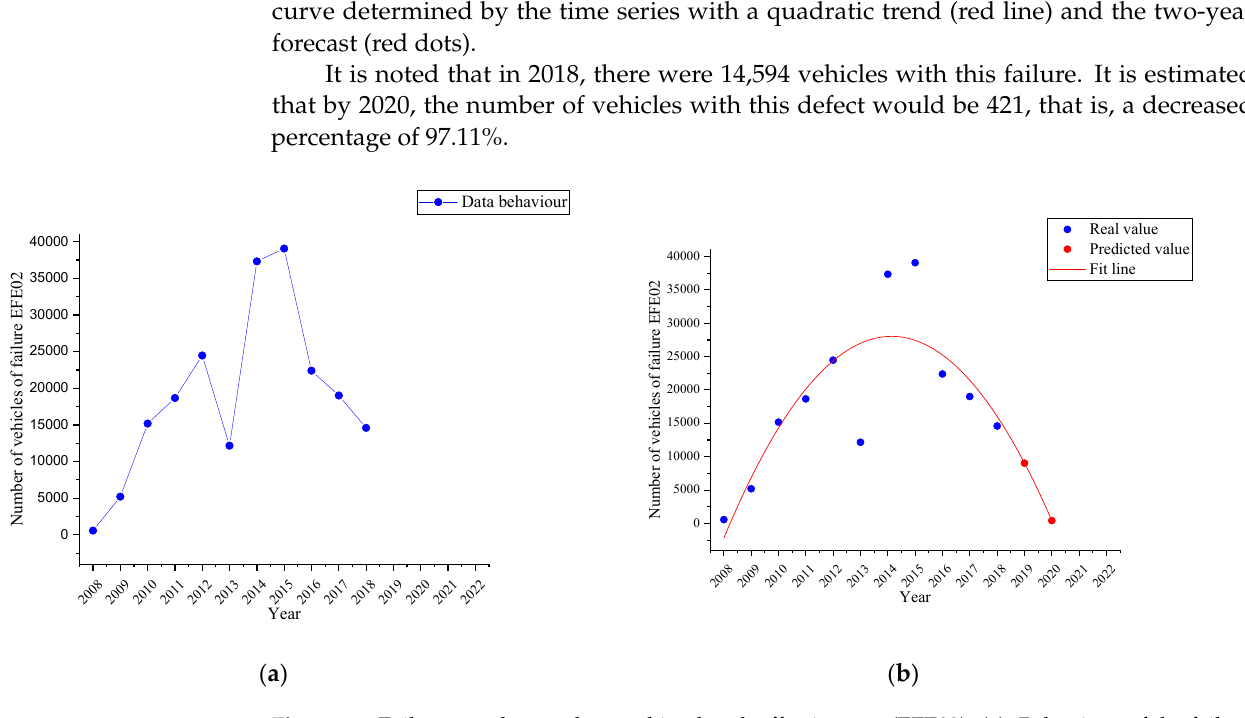
Figure 12. Failure trend named as parking break effectiveness (EFE02). ( a ): Behaviour of the failure (blue line); ( b ): the time series with a quadratic trend (red line) and the forecast (red